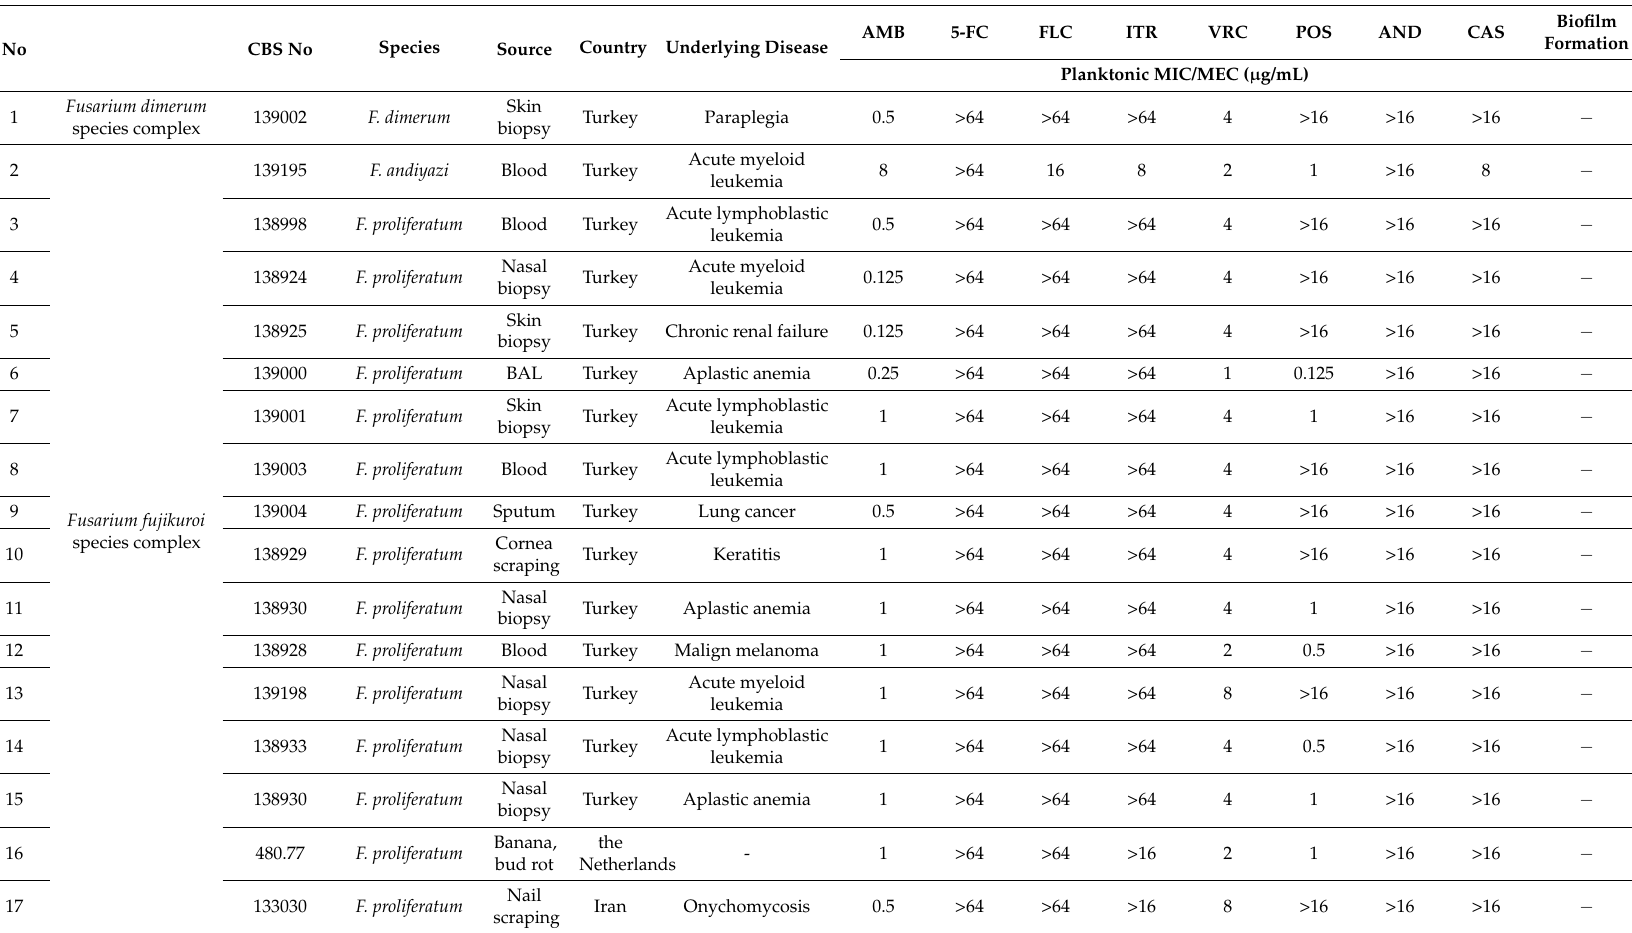
Table 1. Clinical origins, characteristics, the ability to form biofilms and in vitro MICs/MECs, obtained by Clinical and Laboratory Standards Institute